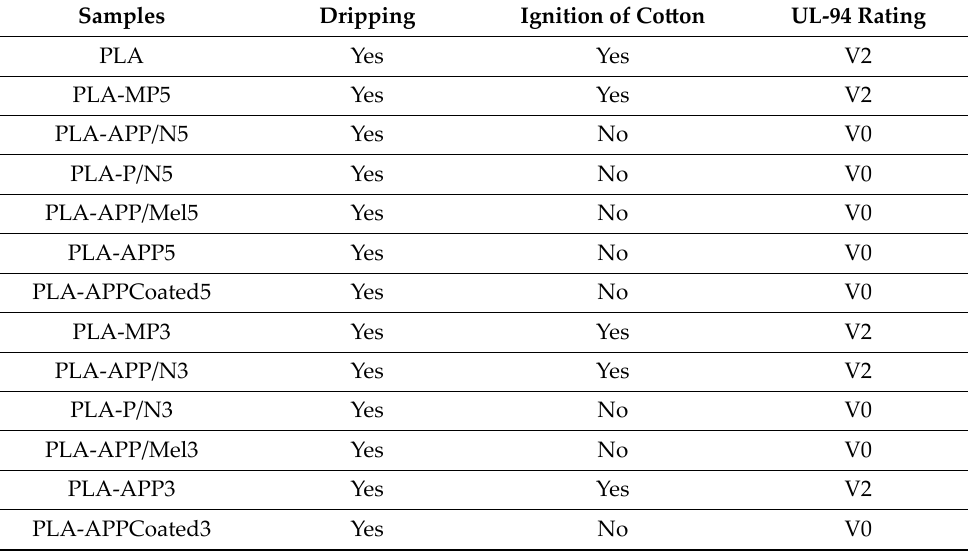
Table 3. UL‑94 vertical burning test results of PLA with different